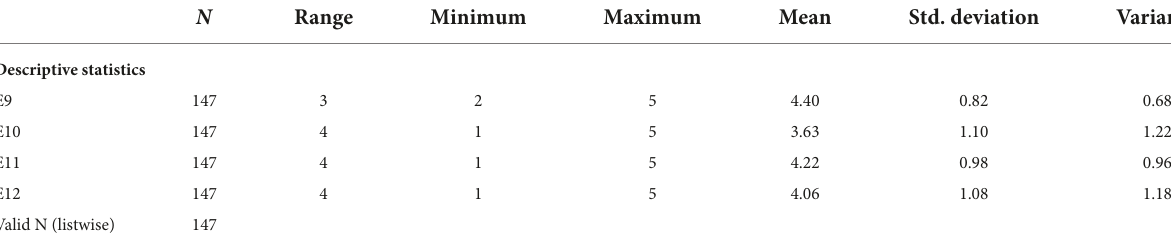
TABLE 4 Logical reasoning of students: descriptive statistics.